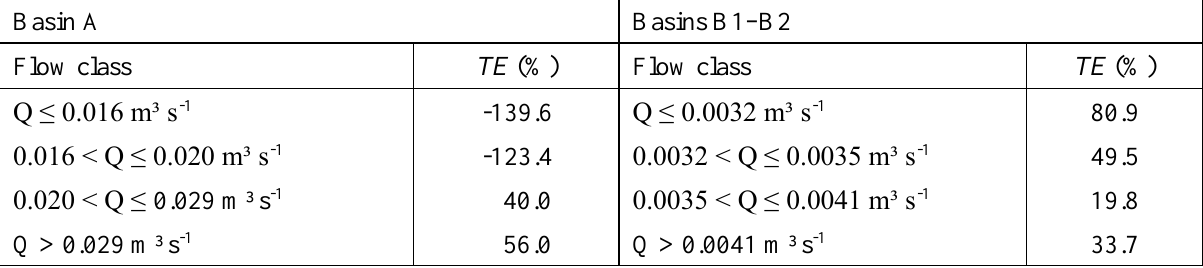
Figure 5. Daily trapping efficiency TE (%) and daily rainfall for Basin A. Table 2. TE (%) of Basin A and Basins B1 – B2 calculated using data from the turbidimeters for the period May – September 2017. Basin